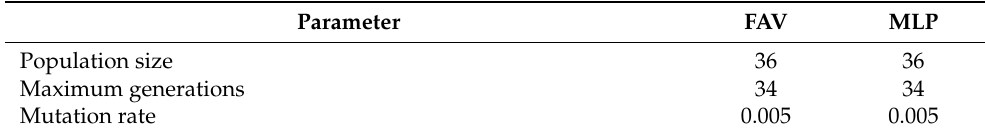
Table 2. Parameters of the developed GA–PLS-1